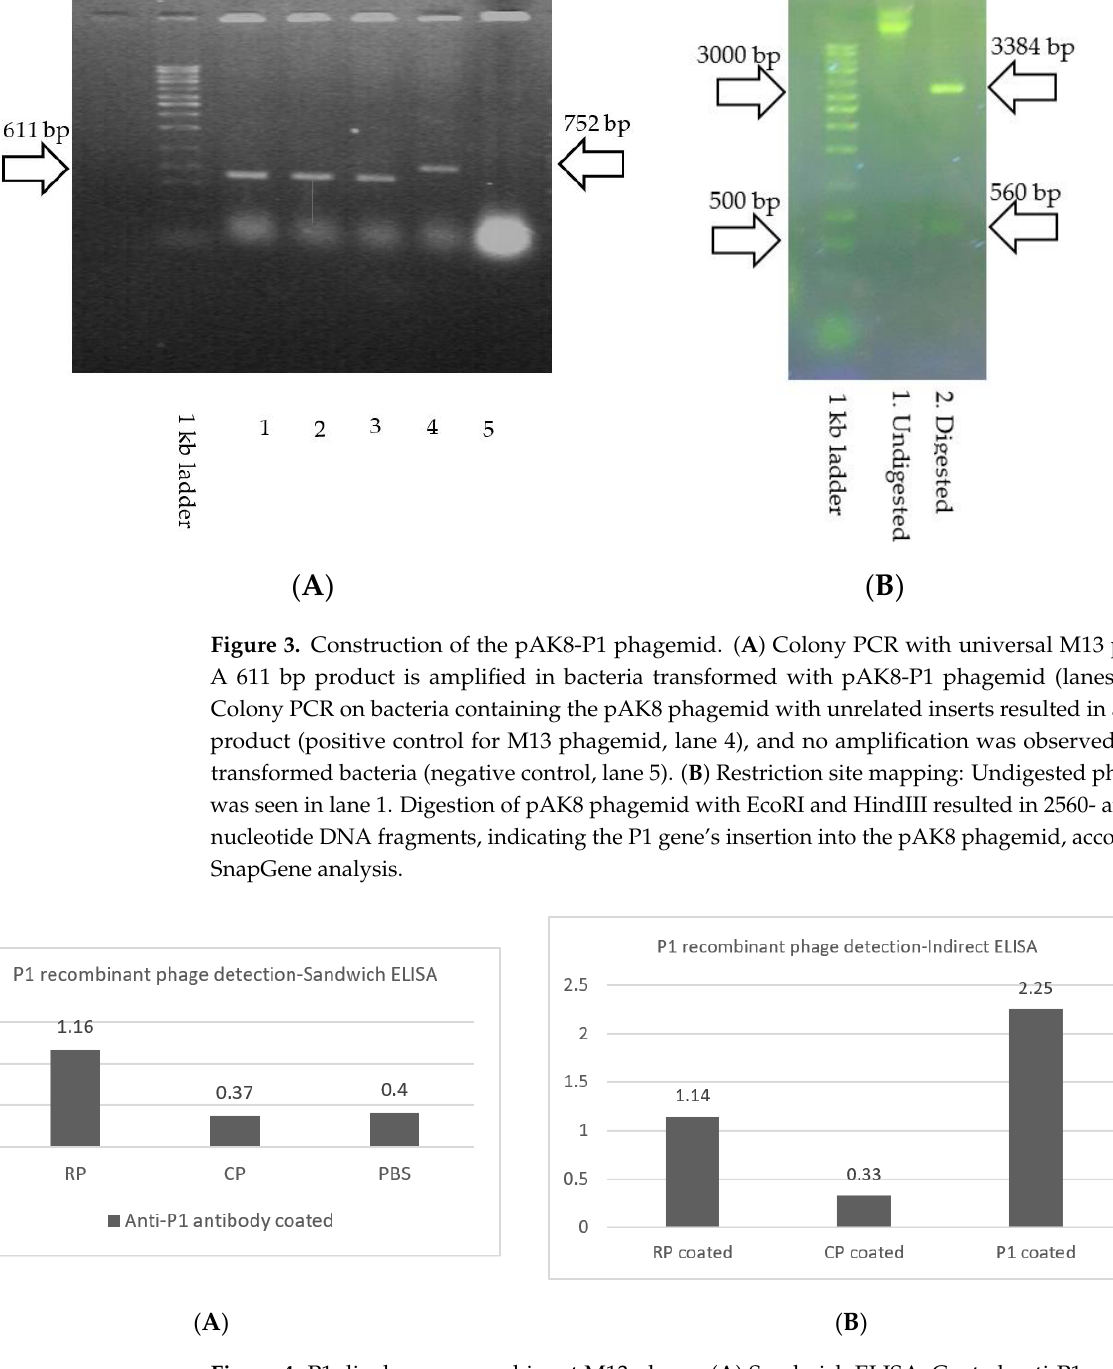
Figure 3. Construction of the pAK8-P1 phagemid. ( A ): Colony PCR with universal M13 primers: A